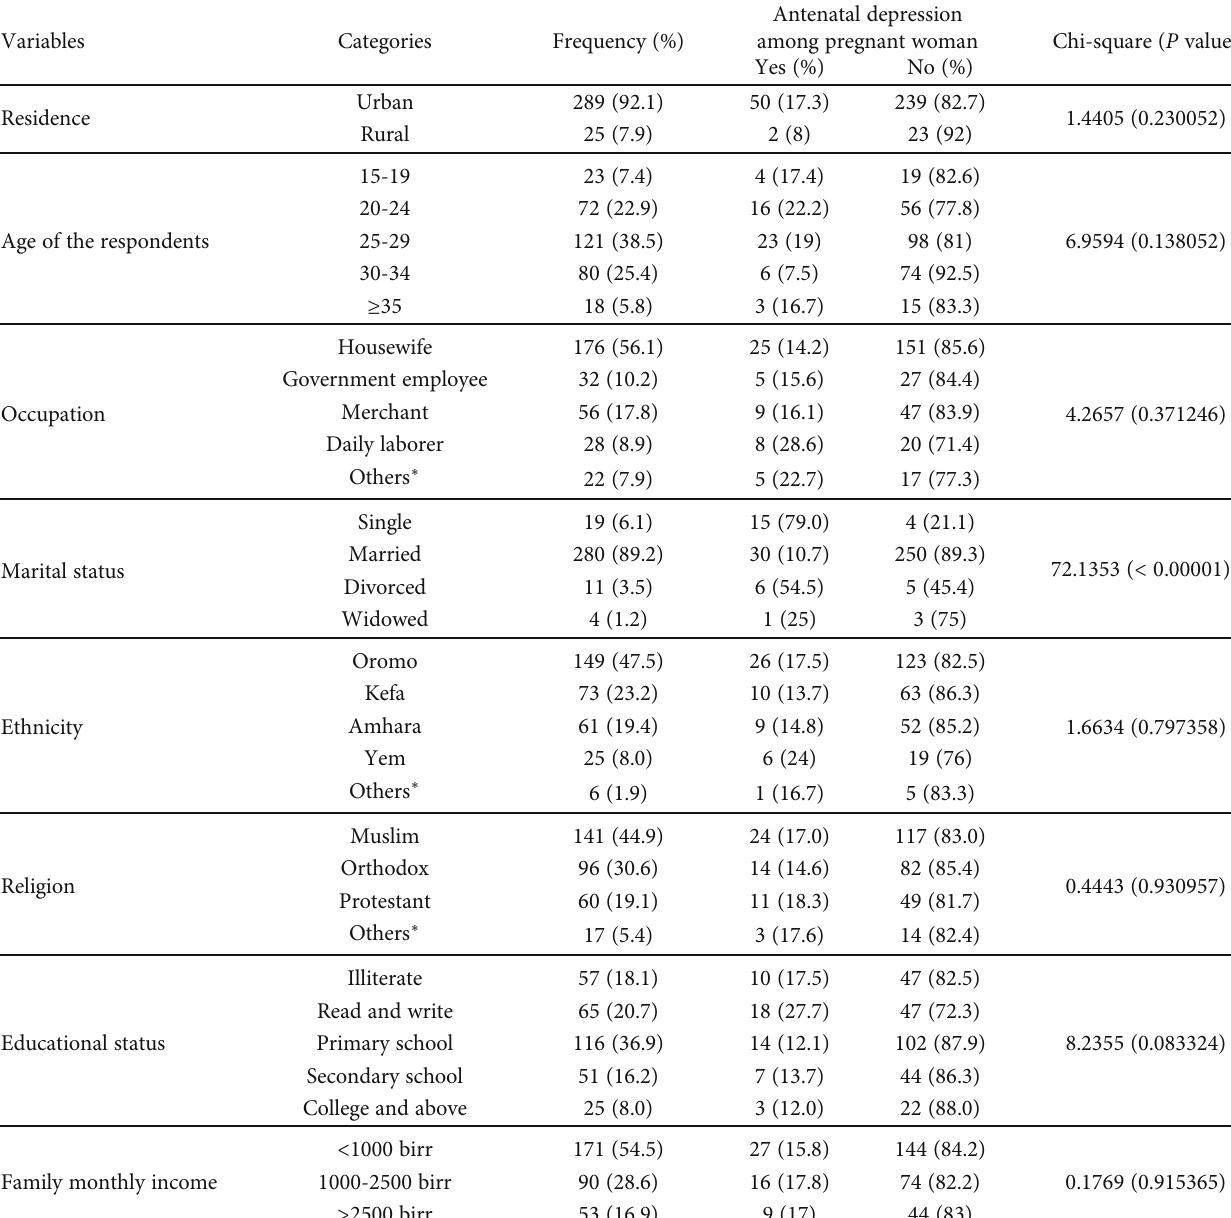
Table 6: Factors associated with antenatal depression among pregnant women in Kochi Health Center, Jimma town, southwest Ethiopia,